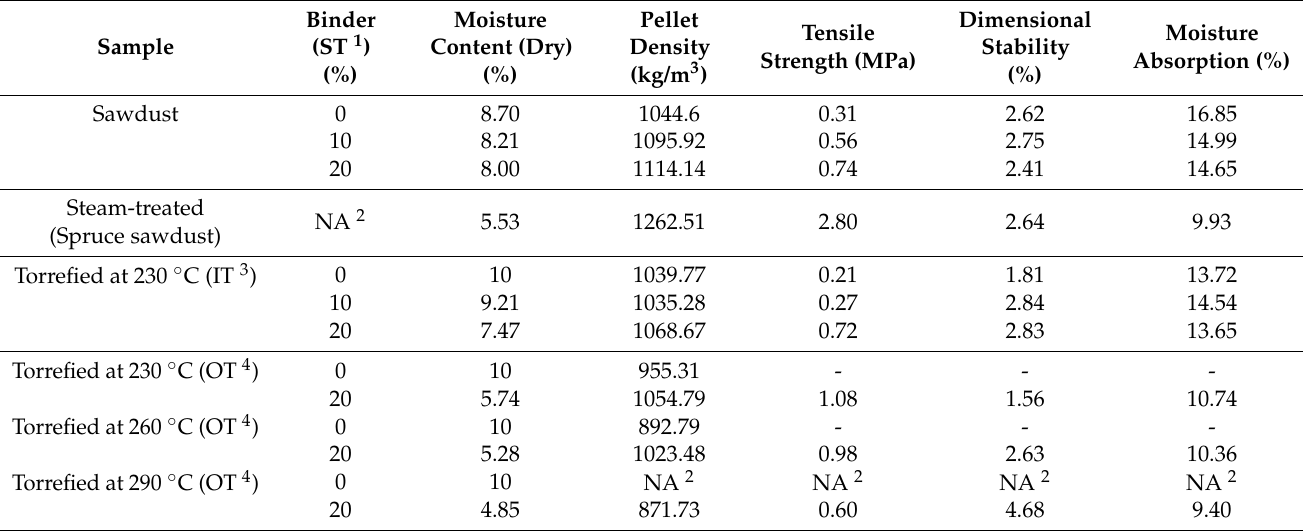
Table 7. Mean values of physical and mechanical properties of treated and non-treated pellets.